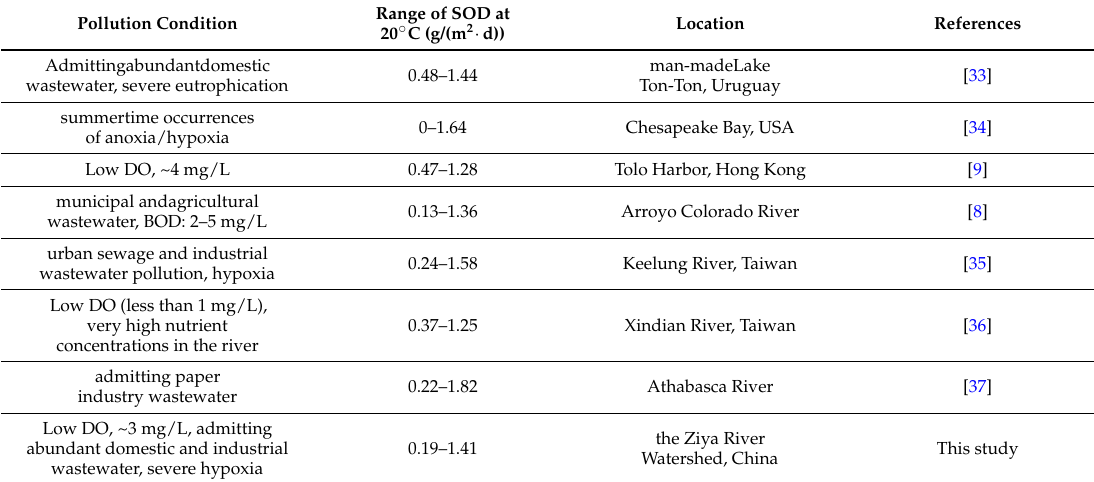
Table 3. ComparativeSOD values reportedby various